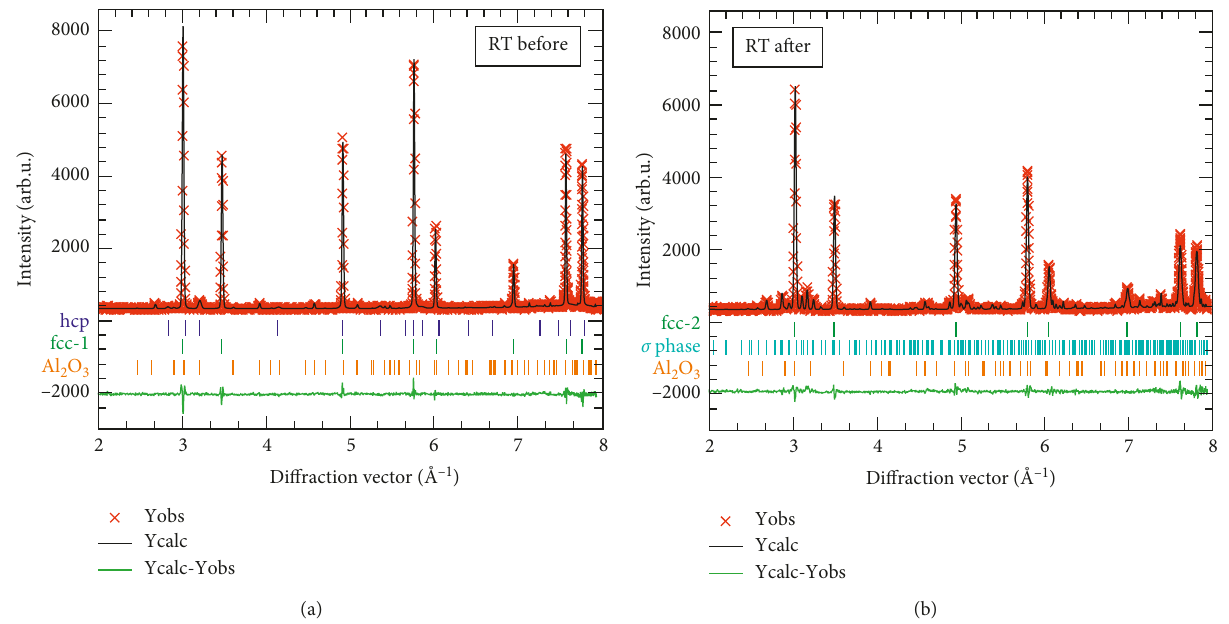
Figure 2: Measured and calculated diffraction patterns at room temperature before (a) and after (b) the thermal cycle. Bragg positions for individual phases are displayed as well.